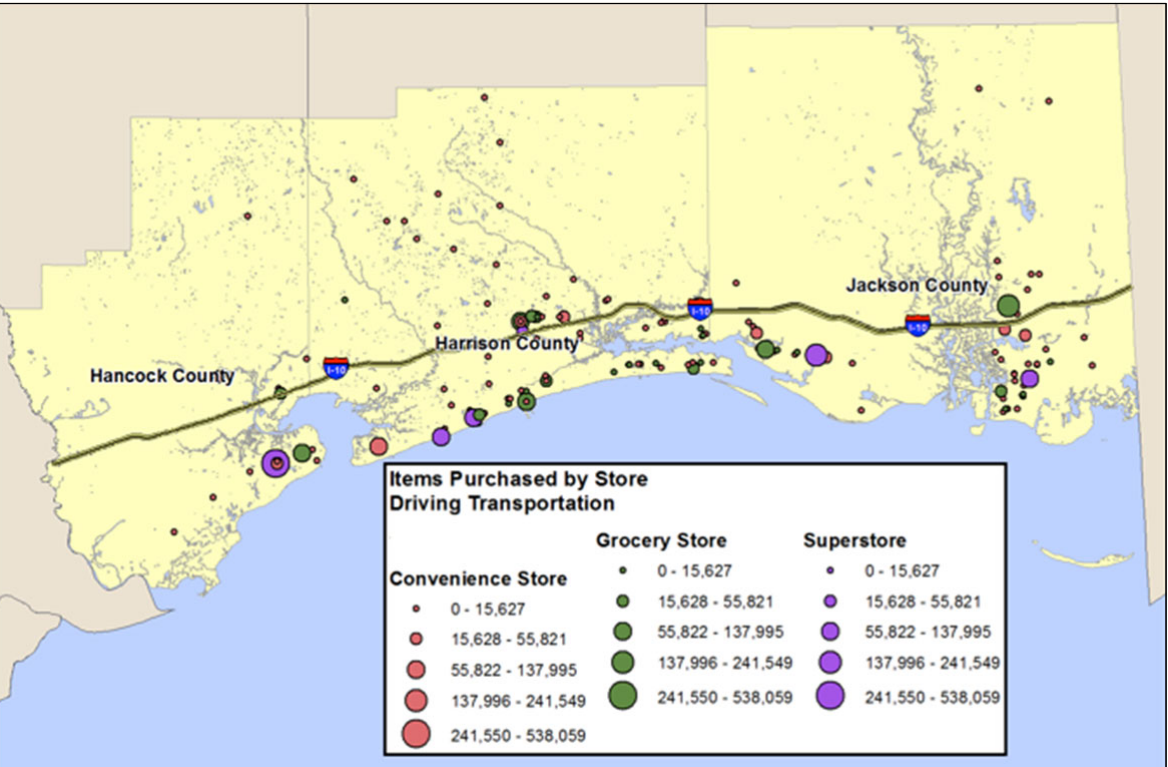
Figure 9. Map of the stores and their estimated frequency of usage (number of items purchased per store) by residents in the Gulf Coast counties of Mississippi, if they were to purchase all items in the USDA Thrifty Food Plan during spring 2011 at the lowest cost, including both the costs of the food items and transportation by automobile to acquire